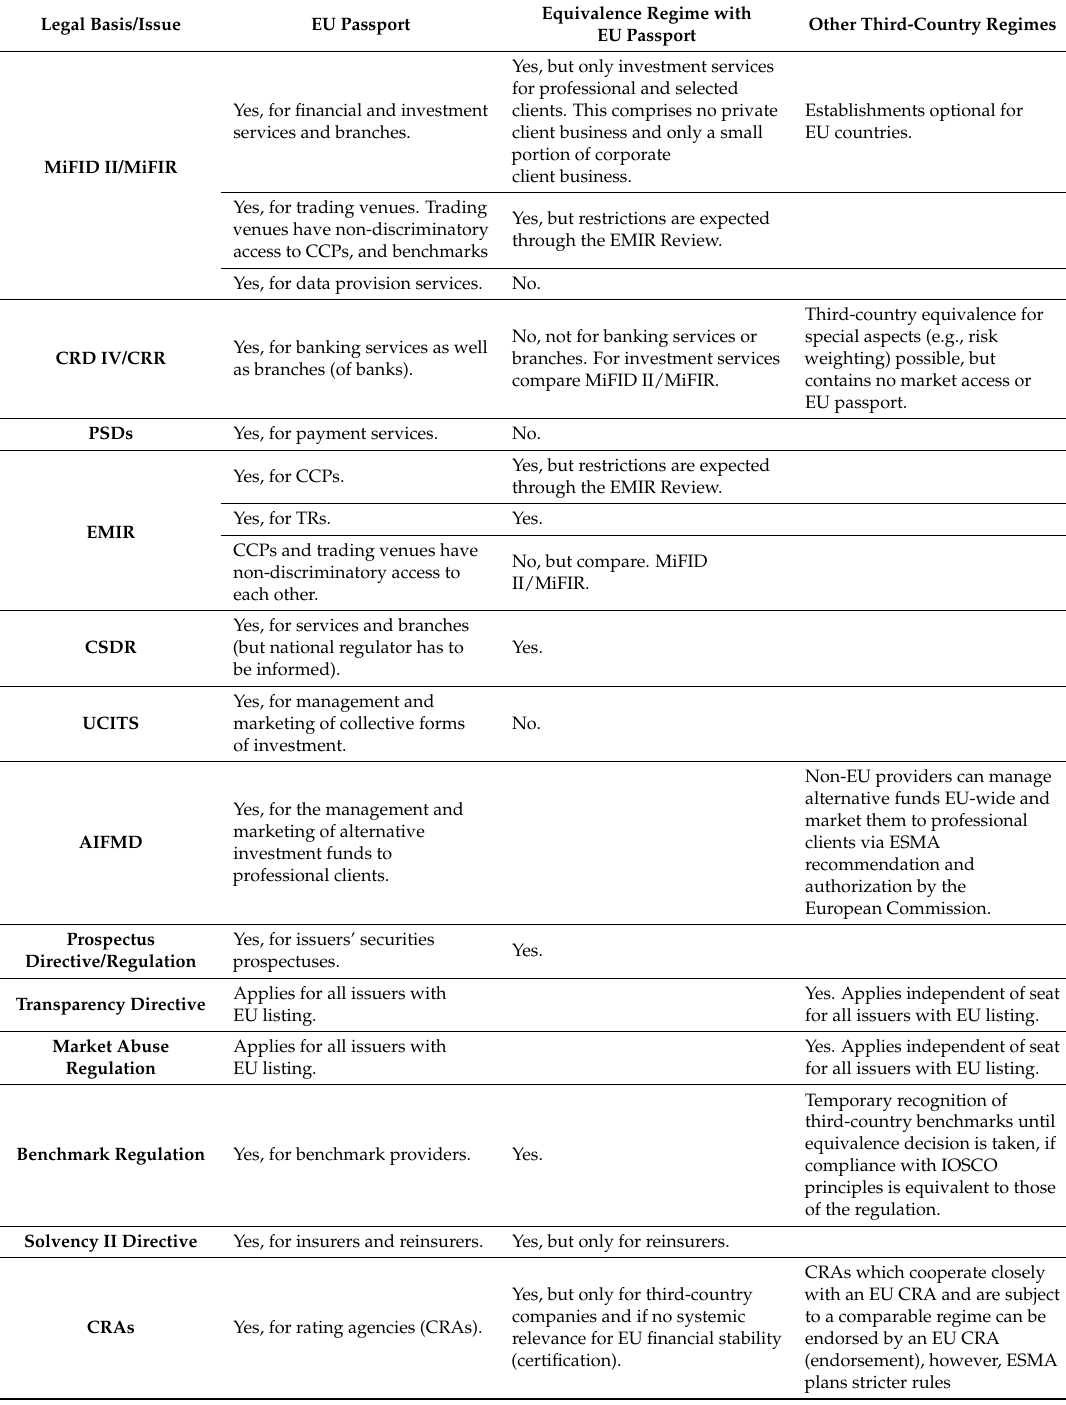
Table 1. EU passporting and third-country regimes in EU financial and capital markets law. Legal